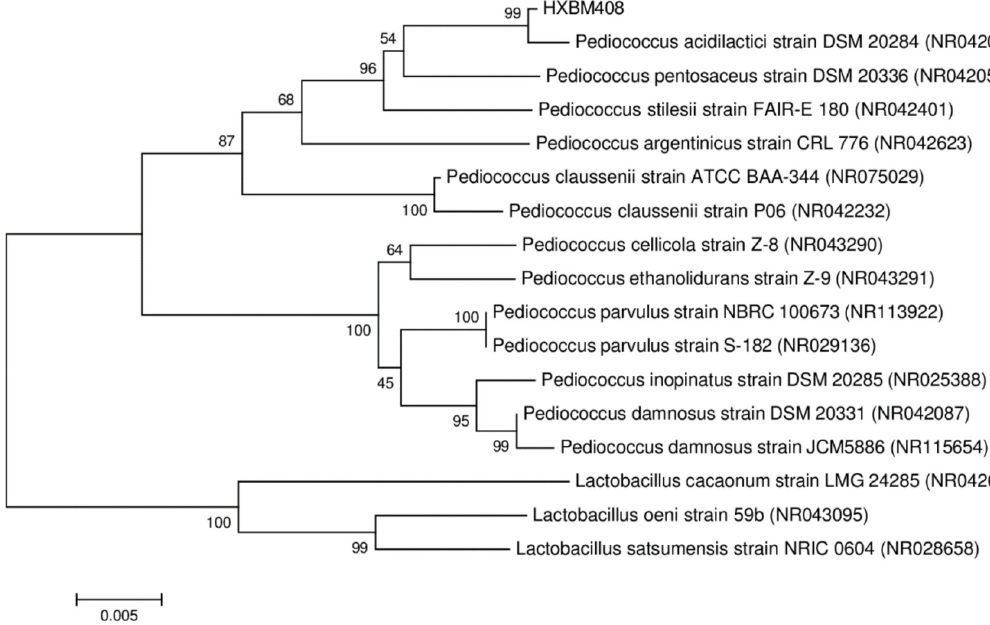
Fig 5. Phylogenetic tree based on 16S rDNA of strain HXBM408 and reference strains. Note: Numbers at nodes represent bootstrap values. Numbers in brackets are the accession numbers of sequences in GenBank. The scale bar "0.01" represents sequence divergence.